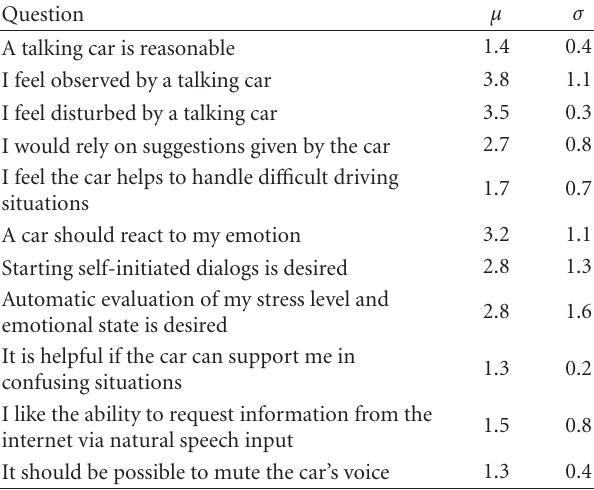
Table 2: Results of system specific questionnaire composed of eleven questions. Mean ( μ ) and standard deviation ( σ ) of ratings on a five point scale (“Strongly Agree” (value = 1) to “Strongly Disagree” (value =